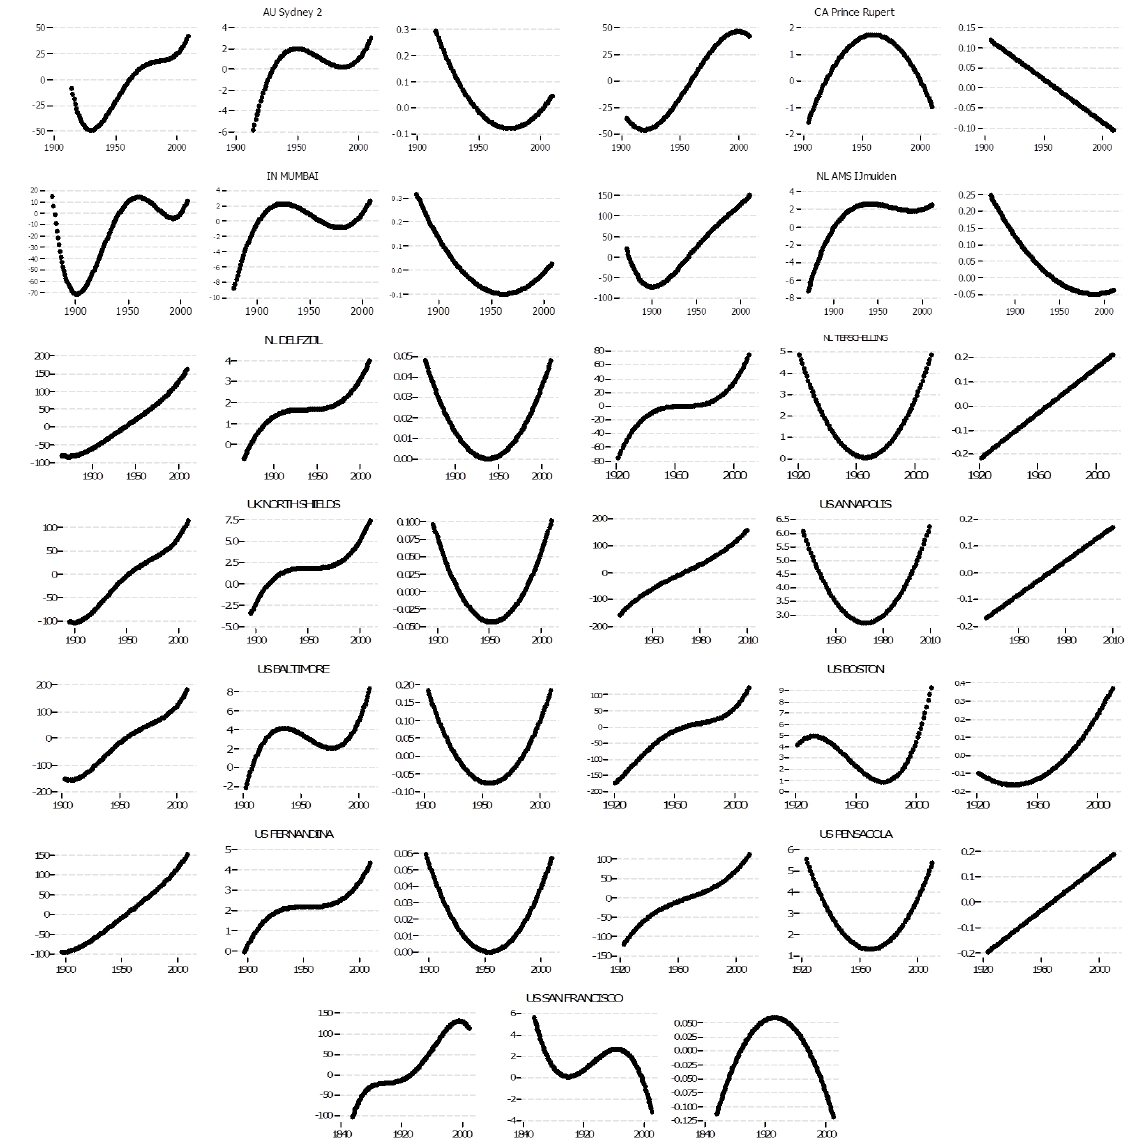
Figure 1. In the first graph of each station, the vertical axes show estimated sea level heights using quartic models in mm referenced to zero intercept. The second graph of each station display the display the sea level velocities in mm/yr which is generated from the estimated quartic parameters using the velocity equation. The accelerations (mm/yr/yr) of each stations are based on the acceleration equation with estimated quartic parameeters. All plots are generated during each stations’ record periods at yearly intervals. Horizontal axes are in years and the initial period of each series are defined at the middle epoch of the series listed in Table